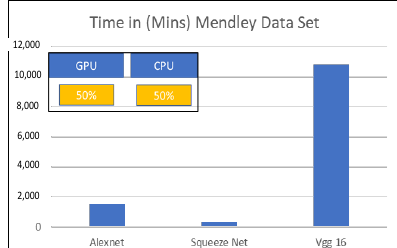
Figure 8. Figure showing a comparison of speed for different classification networks tested on images from the Mendeley DataSet, for details please see